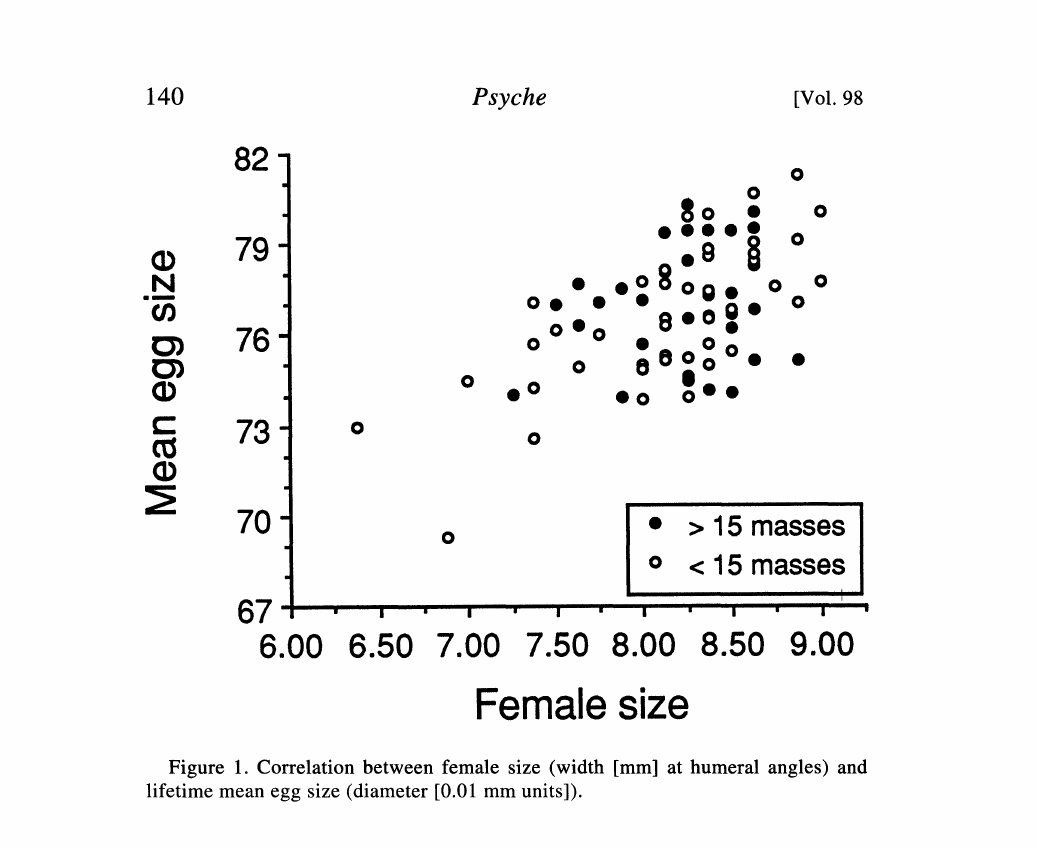
Figure 1. Correlation between female size (width [mm] at humeral angles) and lifetime mean egg size (diameter [0.01 mm units]). copulation, but did not correlate with egg size in later